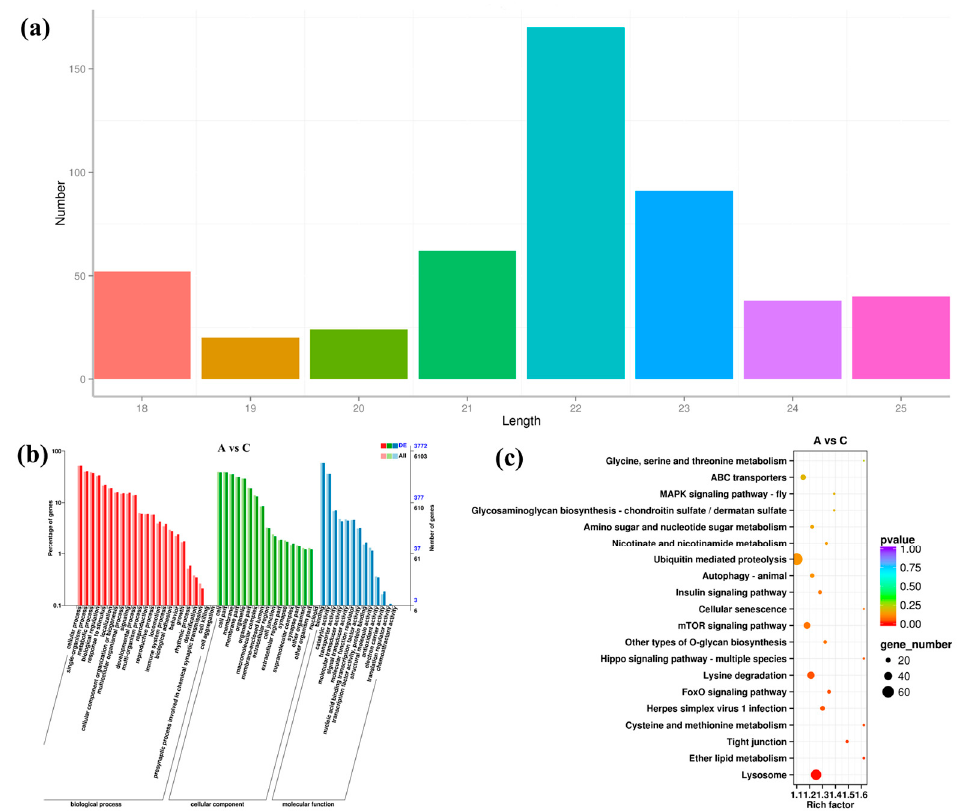
Figure 4. Identification and analysis of DEMis under salinity stress. ( a ) Sequence length of all identified miRNAs. ( b ) GO enrichment analysis of DEMis in groups A vs. C. ( c ) KEGG enrichment analysis of DEMis in groups A vs. C.